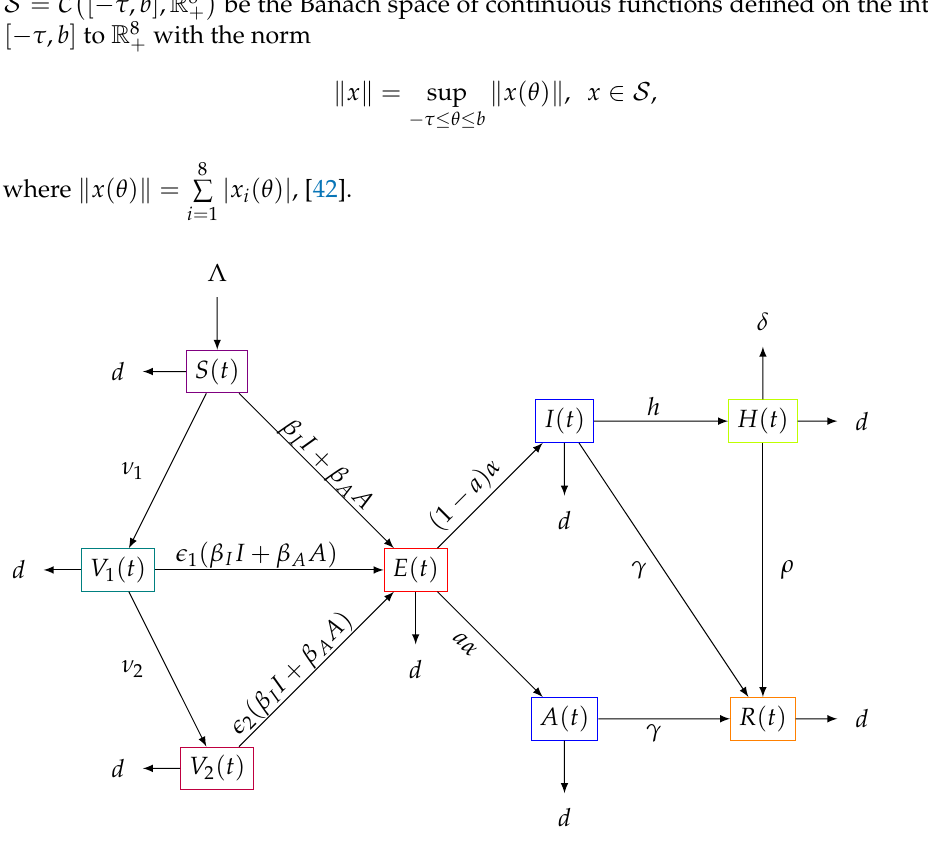
Figure 1. Flow diagram of the transit of the subpopulations over time of the model